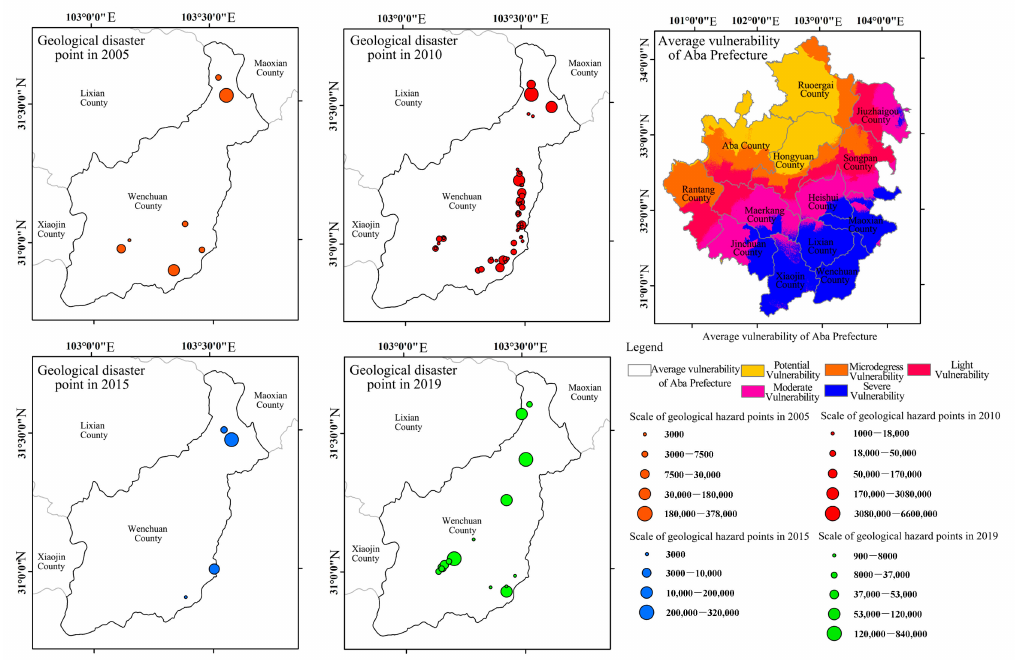
Figure 8. Spatial distribution of socio-ecological vulnerability in Wenchuan County,